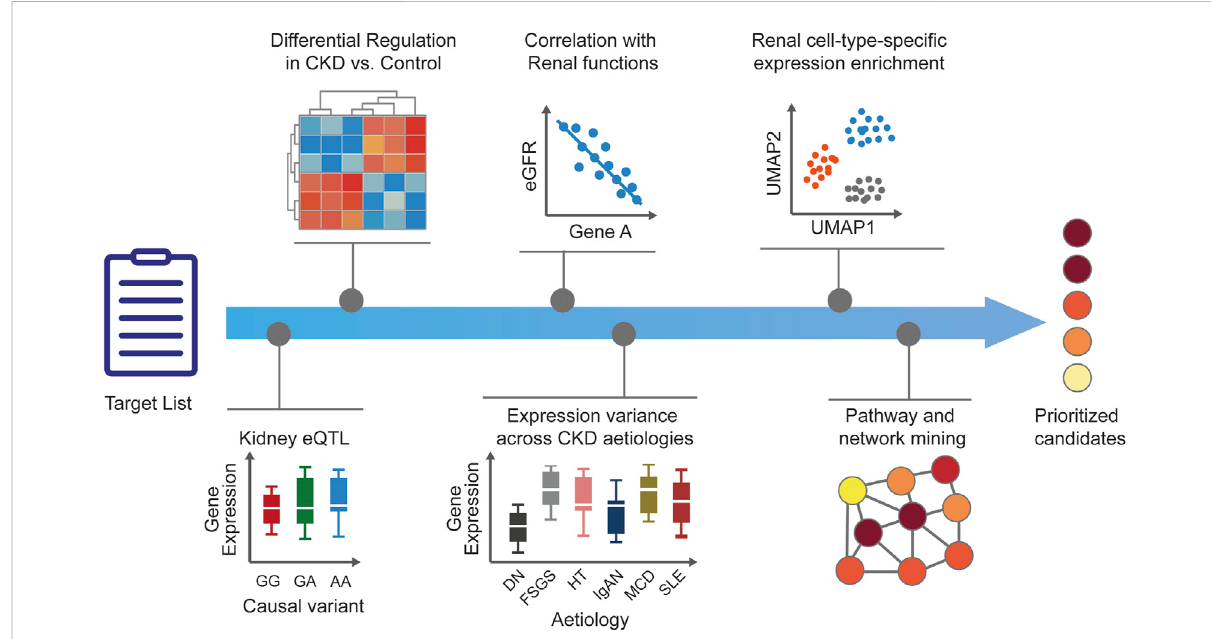
FIGURE 2 Human target validation and prioritization. After generation of CKD target lists, additional disease-relevant evidence is added to generate testable hypotheses and to prioritize the candidates. Tissue-speci fi c expression enrichment and expression modulation in disease versus healthy states help to ascertain the role of targets in CKD. Correlation of targets with renal functional biomarkers and parameters is ascertained and target expression across CKD stages or etiologies is explored to add con fi dence around disease relevance. Prediction of target kidney cell type is useful for guiding downstream in vitro validation and assay selection. Pathway and network analyses can provide additional biological context for dysregulatedcellularmechanismsandhelpinferpotentialmechanismsofaction.Theaccumulatedevidencesupportinghumantargetvalidationand mechanism of action results in a set of prioritized candidates for further experimental validation. CKD, chronic kidney disease; DN, diabetic nephropathy; eGFR, estimated glomerular fi ltration rate; eQTL, expression quantitative trait loci; FSGS, focal segmental glomerulosclerosis;